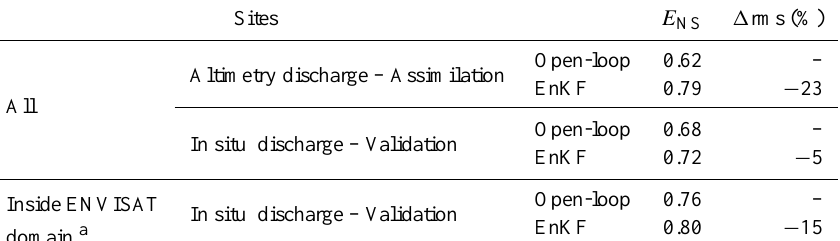
Table 3. As Table 1 but for Exp.